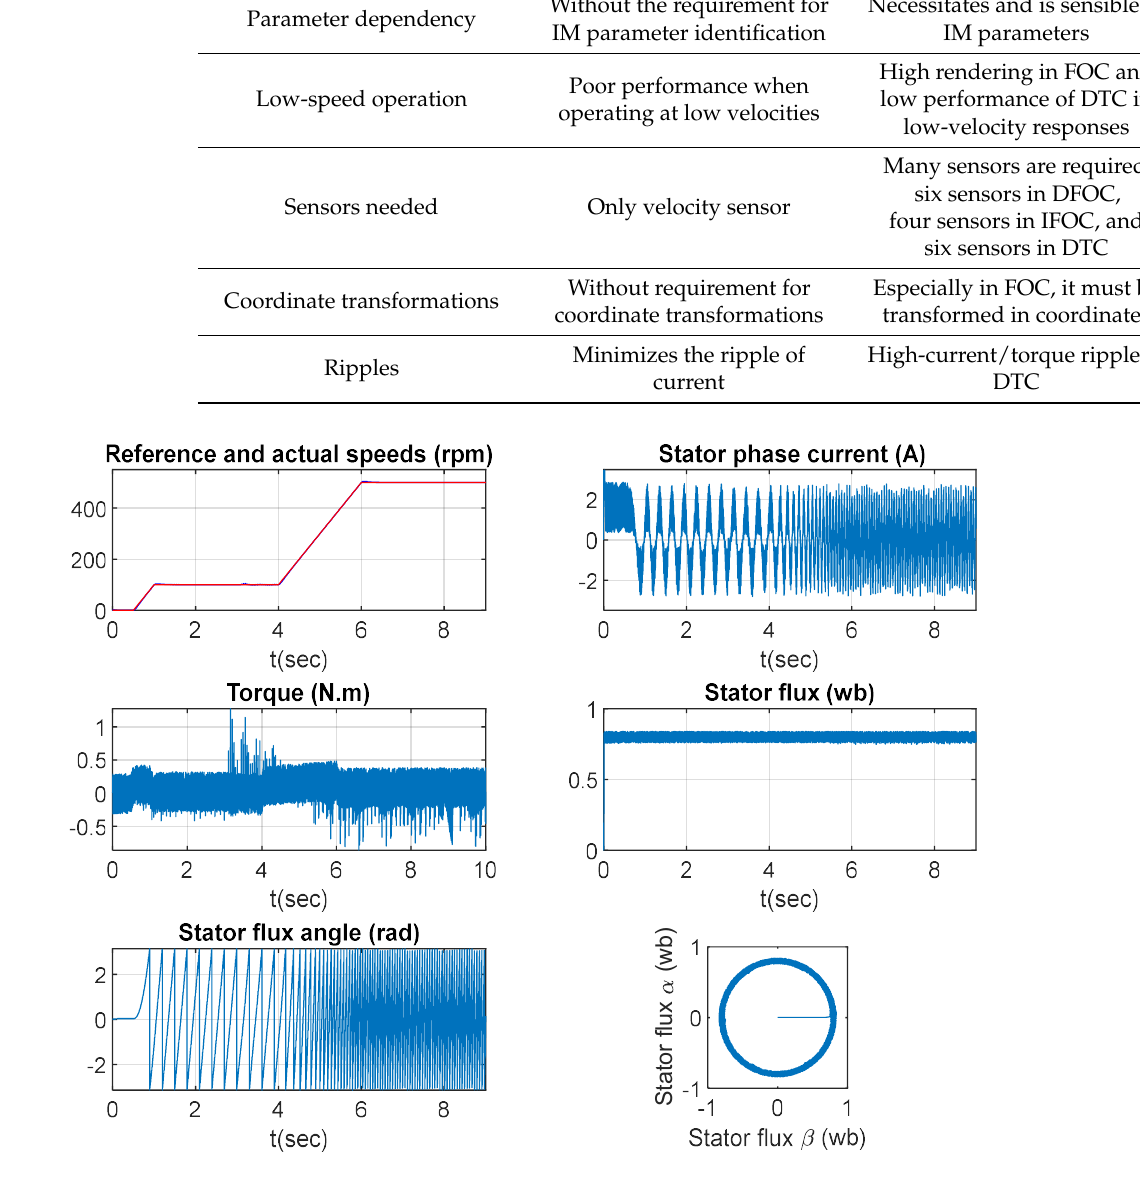
Figure 13. Performance of DTC IM drive.